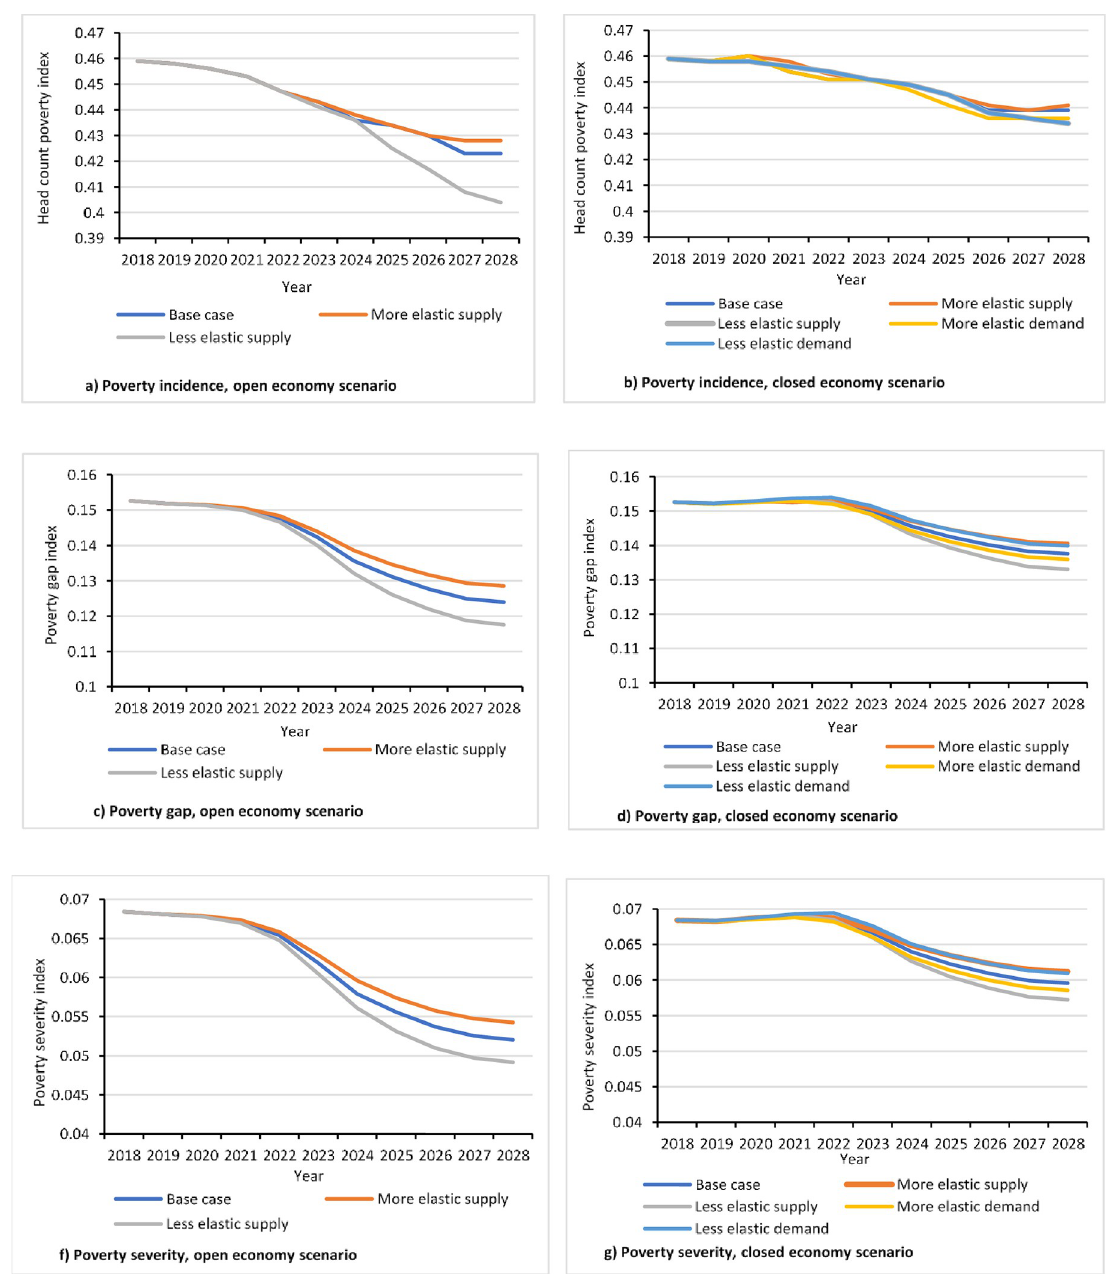
Fig 9. Sensitivity of poverty indices to changes in supply and demand